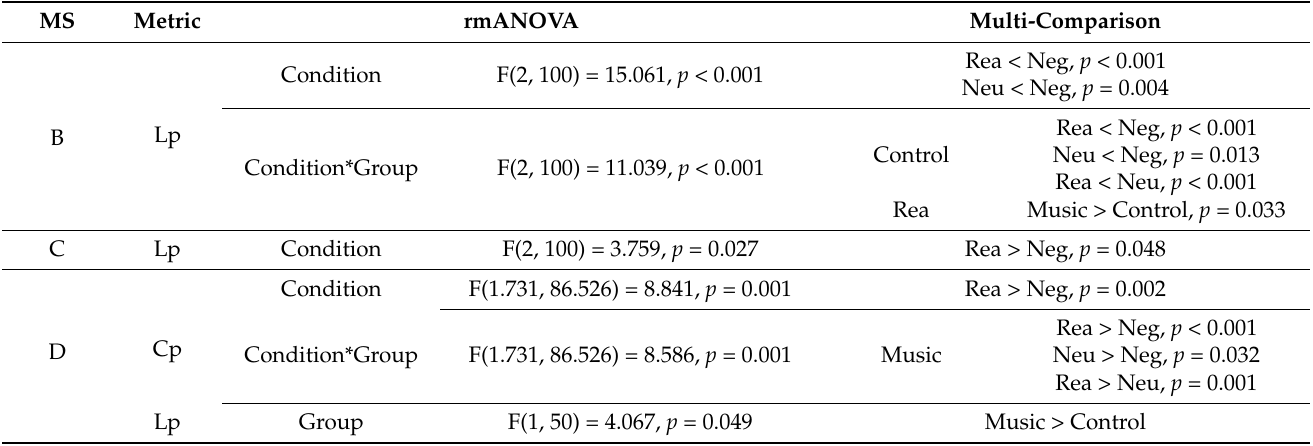
Figure 5. Cp and Lp statistical data of microstates (annotations * denote the significant interaction effect, p < 0.05). Table 2. The significant rmANOVA results of Cp and